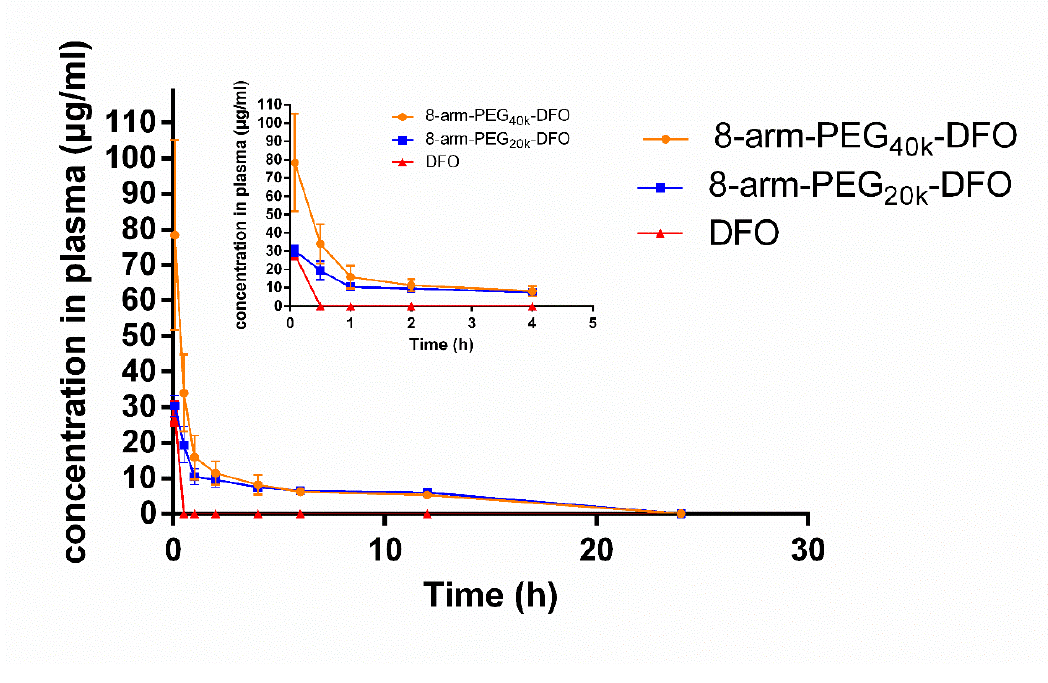
Figure 6. The plasma concentration–time curves of DFO, 8-arm-PEG 20k -DFO, and 8-arm-PEG 40k -DFO after intravenous administration in rats. All the concentrations in the curves were normalized to the DFO concentration. Table 1. Pharmacokinetic parameters of 8-arm-PEG 20k -DFO and 8-arm-PEG 40k -DFO. All the parameters in Table 1 were equivalent to DFO (eq. DFO).